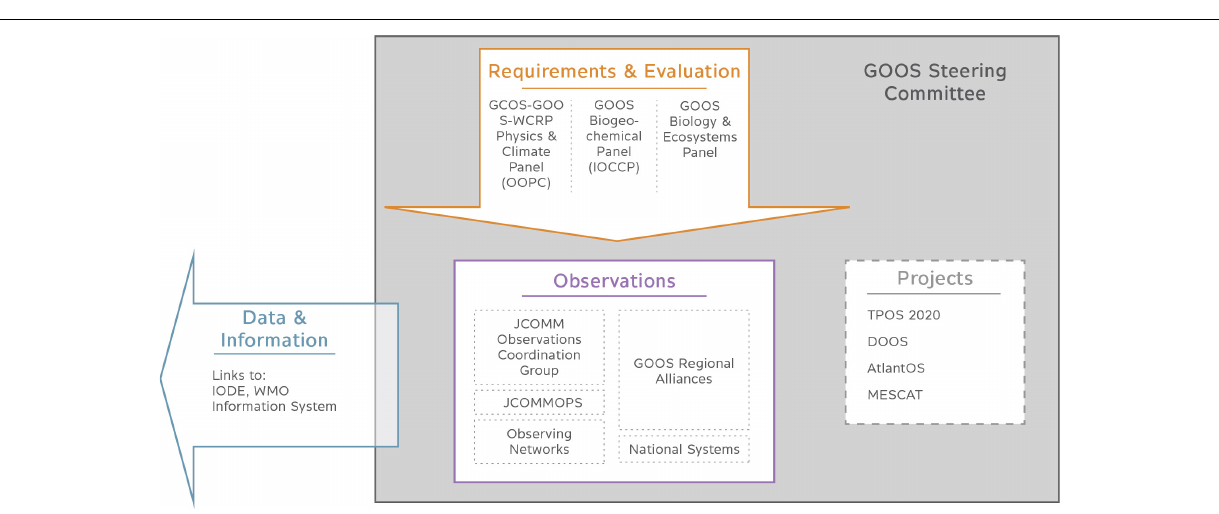
FIGURE 2 | Primary areas of activity and influence for key GOOS elements and linkages in